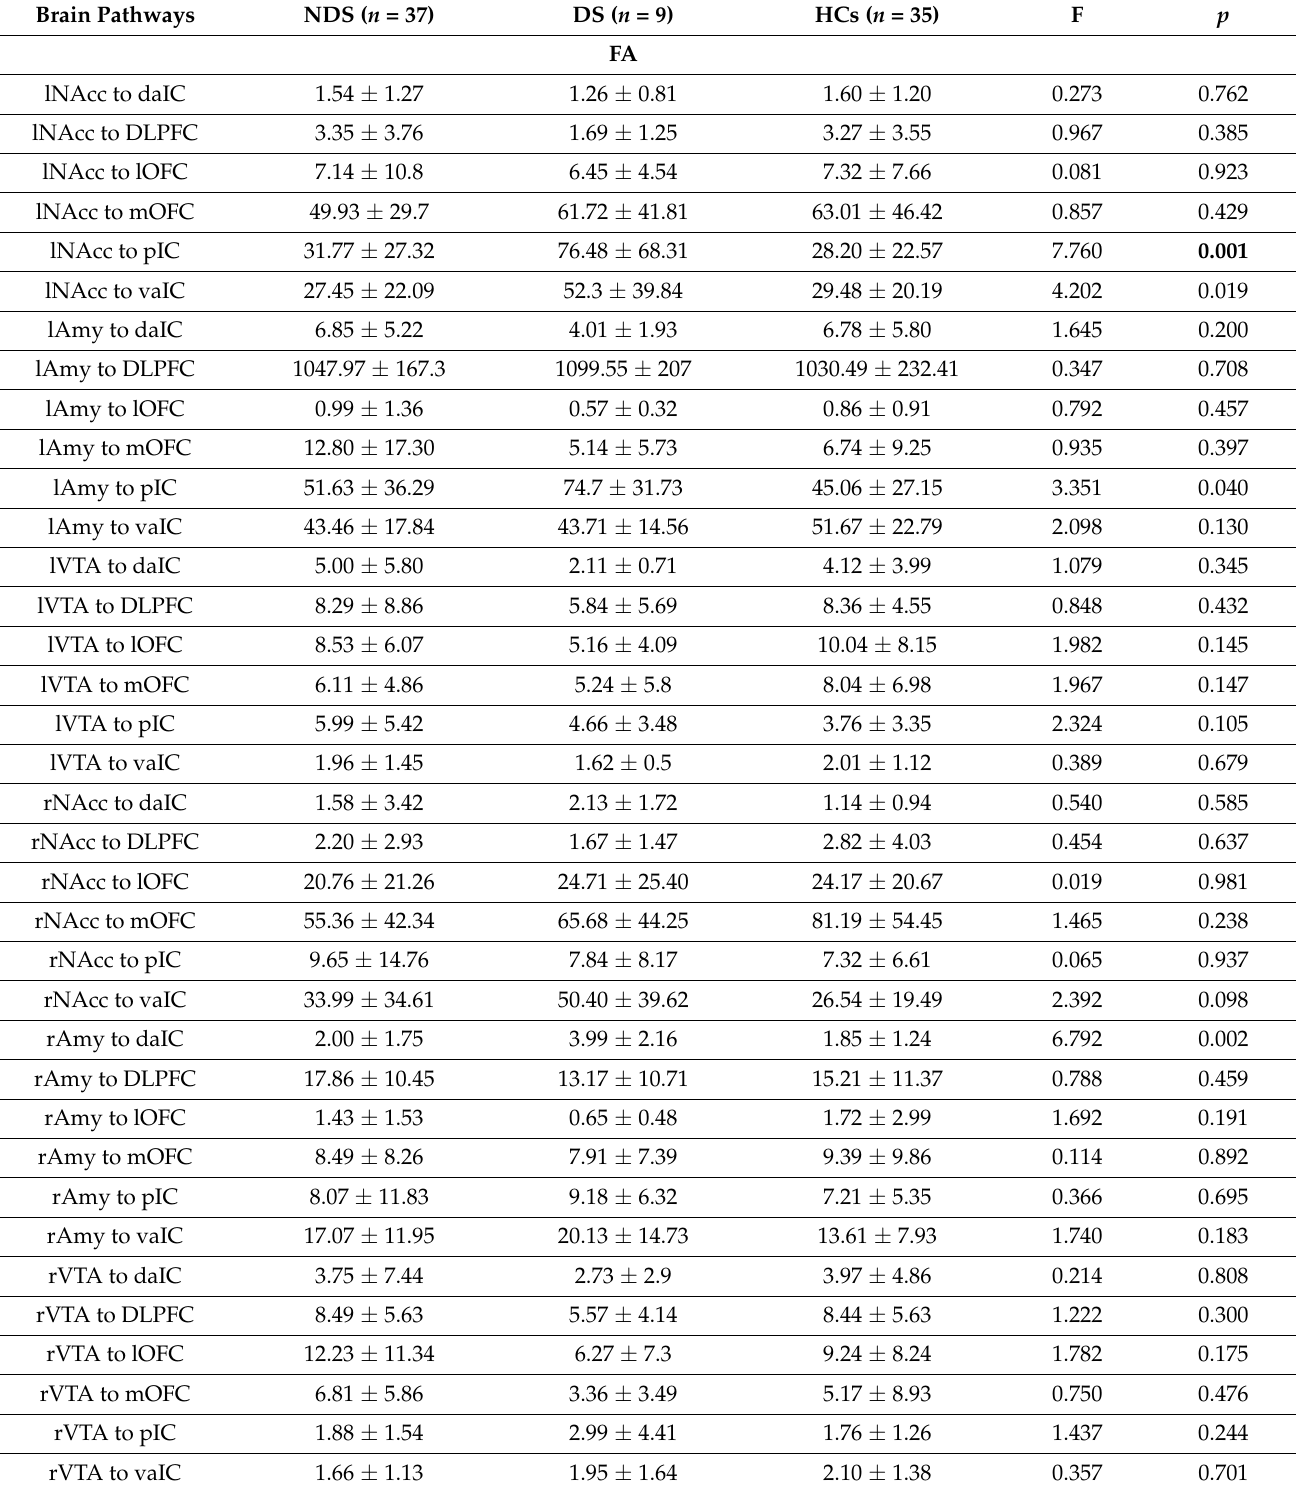
Table 3. Group differences between DS, NDS and HCs in